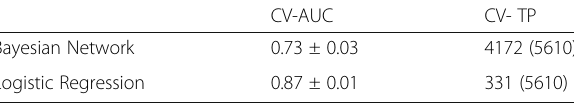
Table 2 AUC values and True Positives from Cross Validation (CV). Processed by authors